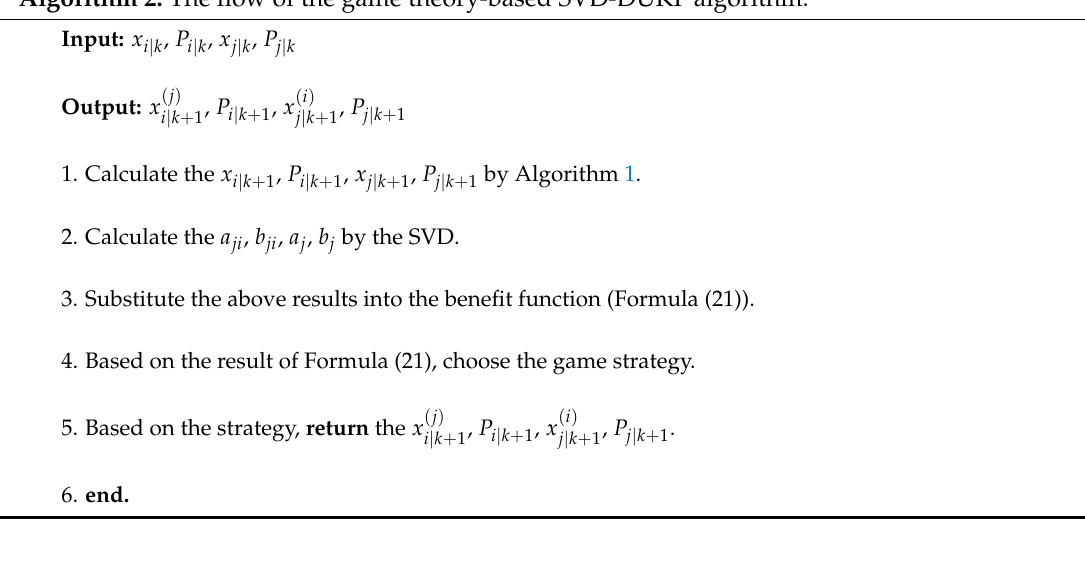
Algorithm 2: The flow of the game theory-based SVD-DUKF